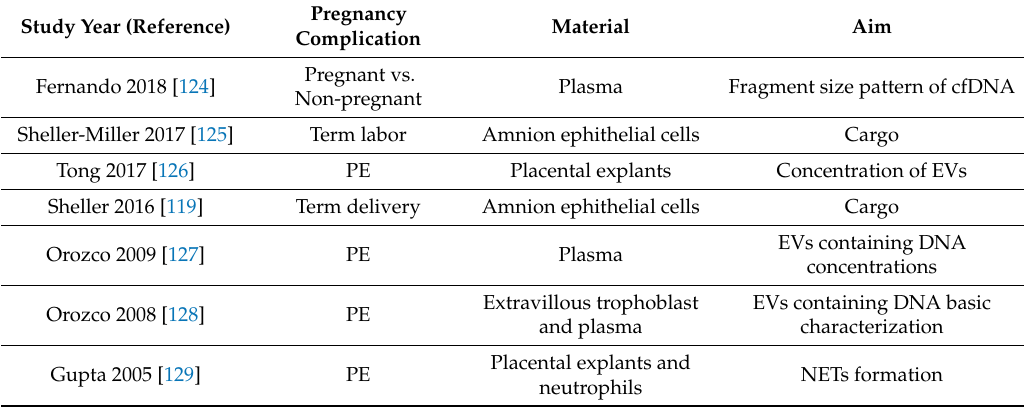
Table 2. Chronological overview of studies regarding DNA and pregnancy